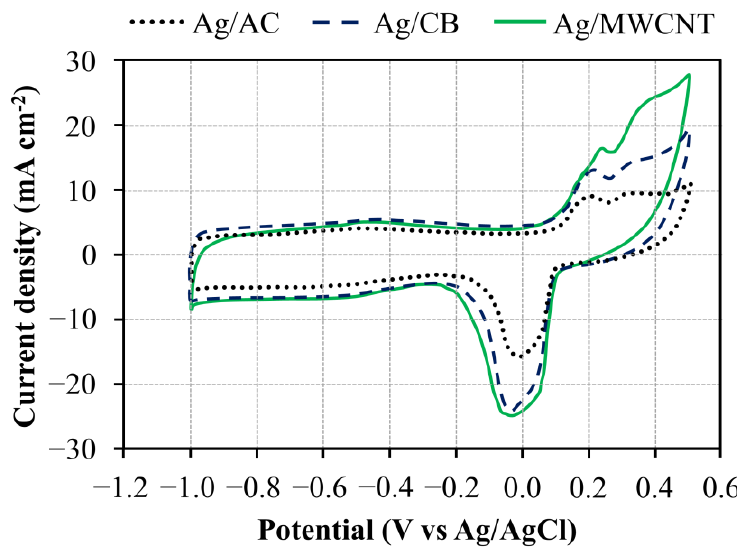
ff erent catalysts in 1 M KOH at scan rate of 100 mV · s − 1 Figure 7. Cyclic voltammetry (CV) of different catalysts in 1 M KOH at scan rate of 100 mV·s −1 . Figure 7. Cyclic voltammetry (CV) of di